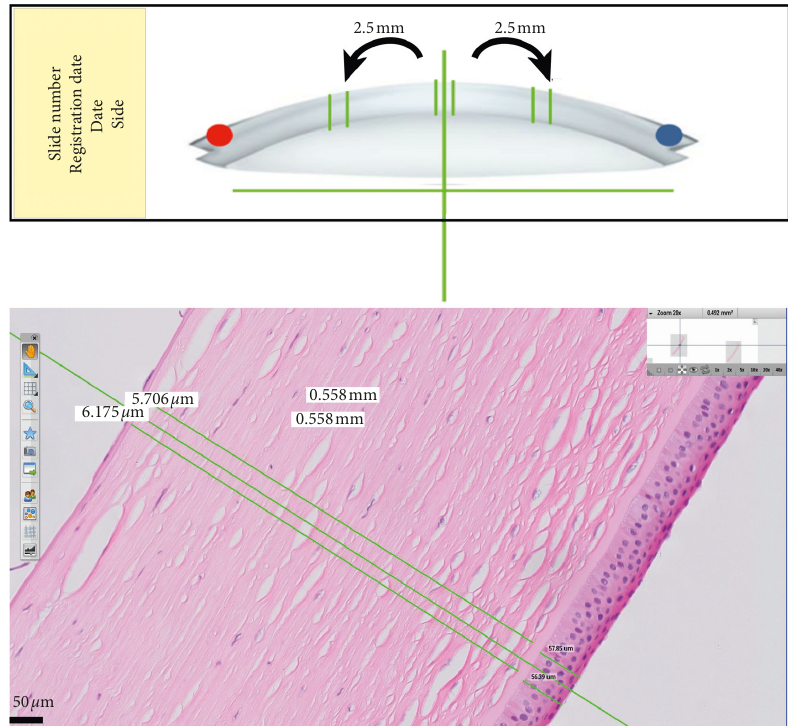
Figure 1: Schematic drawing of the references used to obtain corneal measurements using digital microscopy software (above) and detail of measurements in the corneal samples, hematoxilin-eosin (H&E) staining, 20x magnification